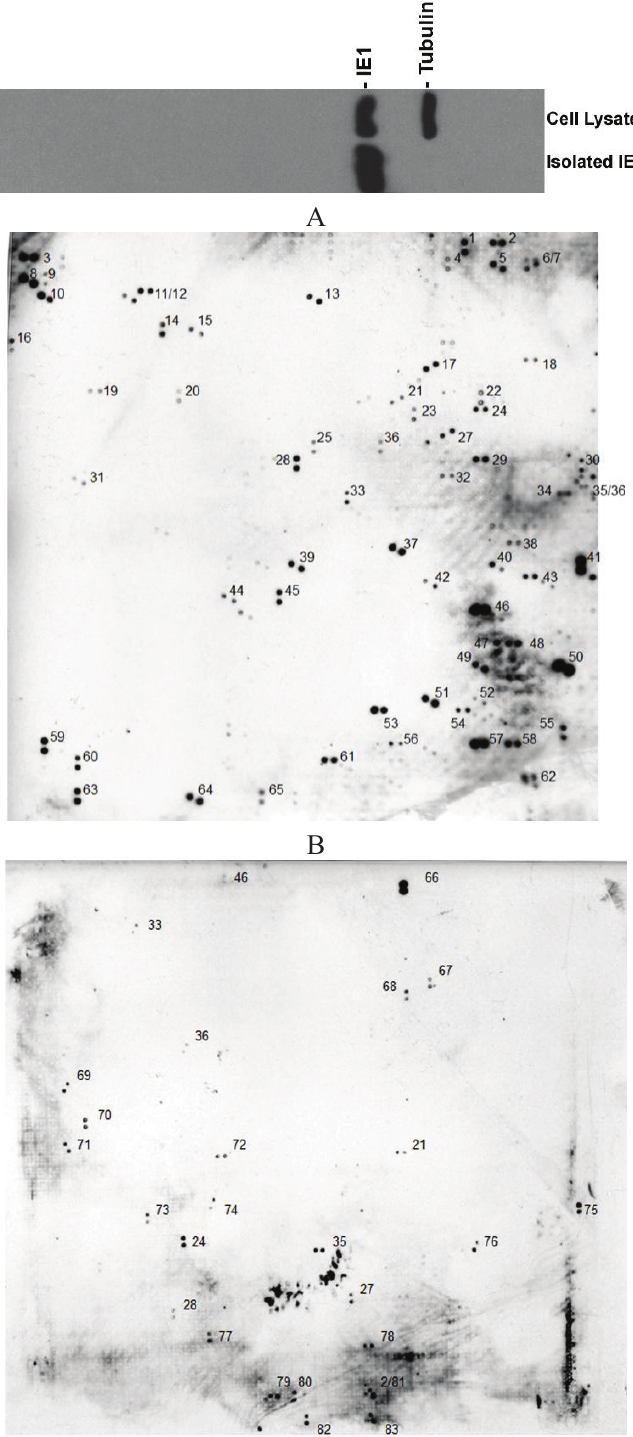
Figure 1. Protein Array. The isolated IE1 was incubated with the two PVDF membranes, which was followed by incubation with a horseradish peroxidase-coupled secondary antibody (GE Healthcare Bio-Sciences, Pittsburgh, PA, USA) and detection with enhanced chemiluminescence (GE Healthcare Bio-Sciences, Pittsburgh, PA, USA), according to standard methods. Some genes overlap between the two PVDF